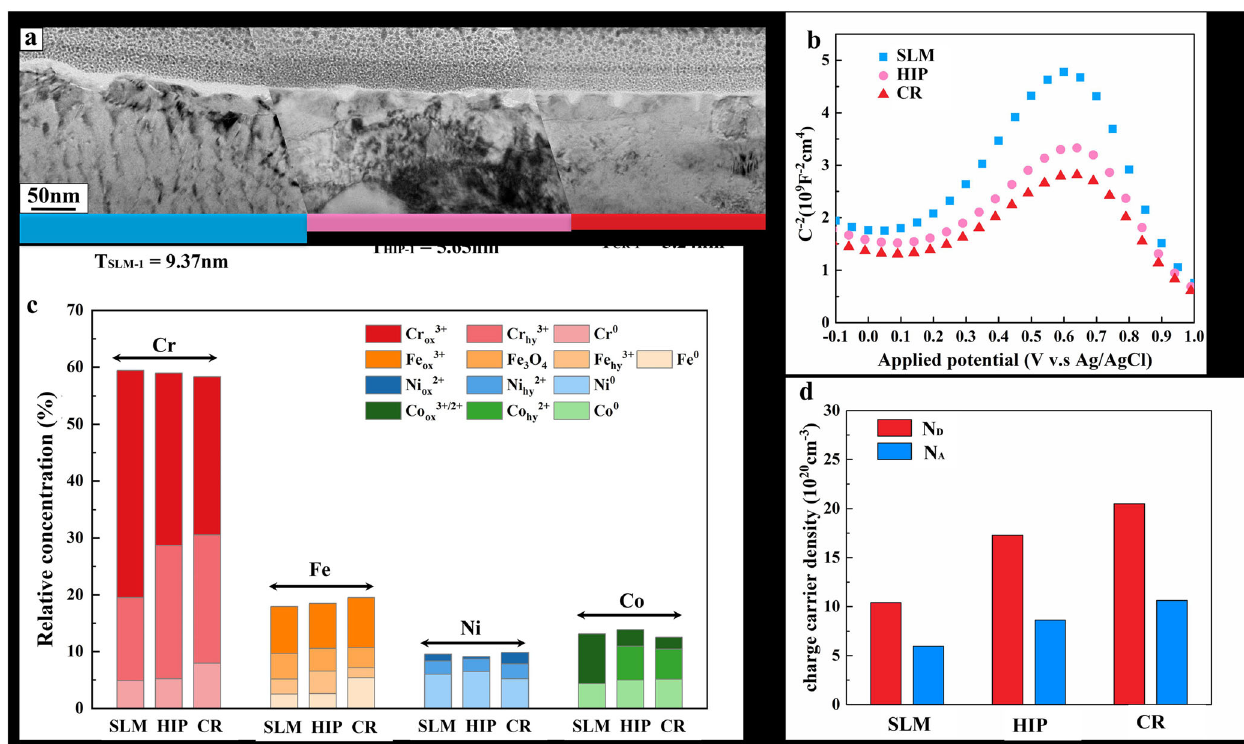
Fig. 3 Analysis of the passive fi lm of the CoCrFeNiN 0.07 HEAs specimens passivated for 3 h in 0.5 M H 2 SO 4 solution at a potential of 0.7 V (within the passive region). a A bright- fi eld TEM images of the cross-section at passive fi lm areas and the measured thicknesses; b Mott- Schottky plots; c calculated relative fraction of the metallic elements in the outmost surface of passive fi lms, and d donor and acceptor densities for passive fi lms on SLM, HIP, and CR